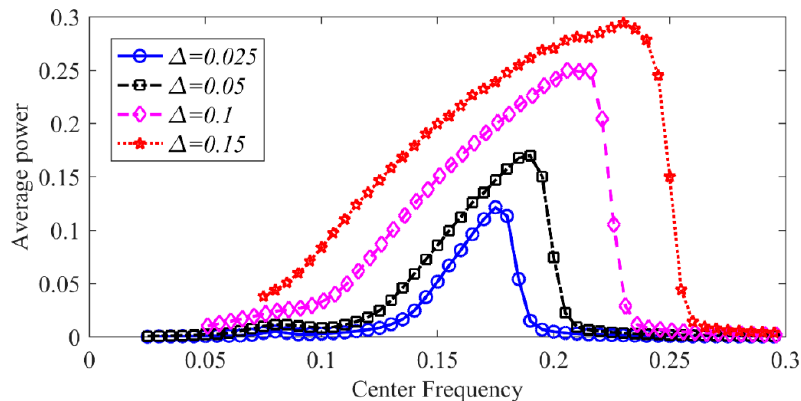
Figure 12. Influence of center frequency on the output performance of the asymmetric MEH excited by band-limited noise with different frequency bandwidth.